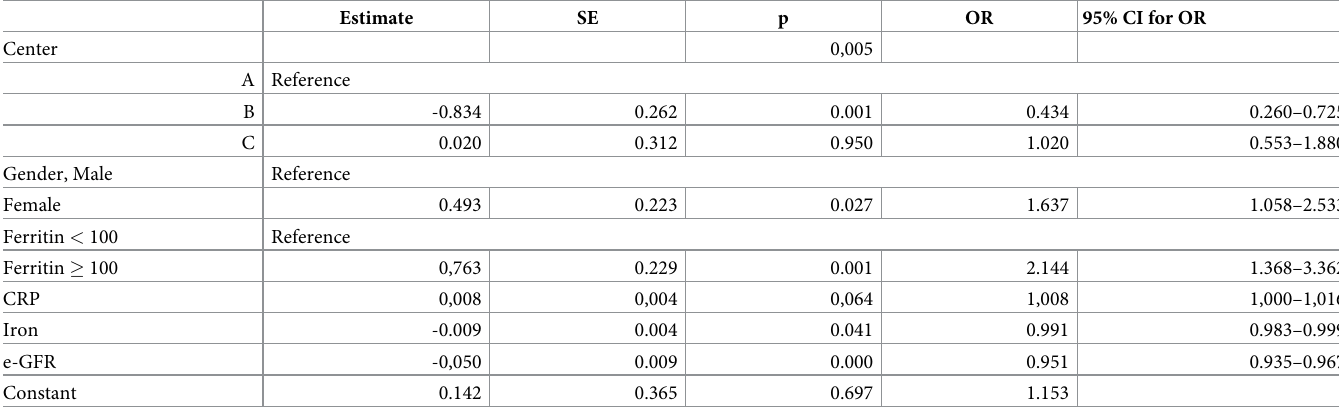
Table 3. Covariates associated with severe